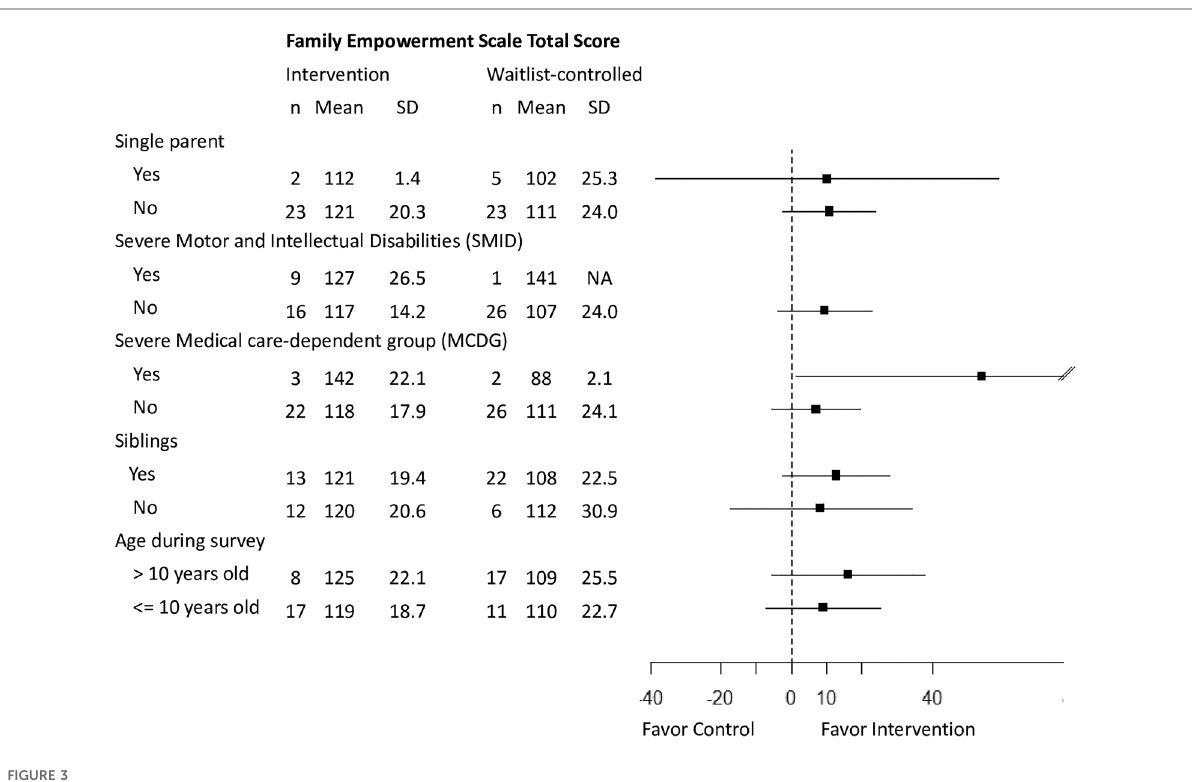
FIGURE 3 Subgroup